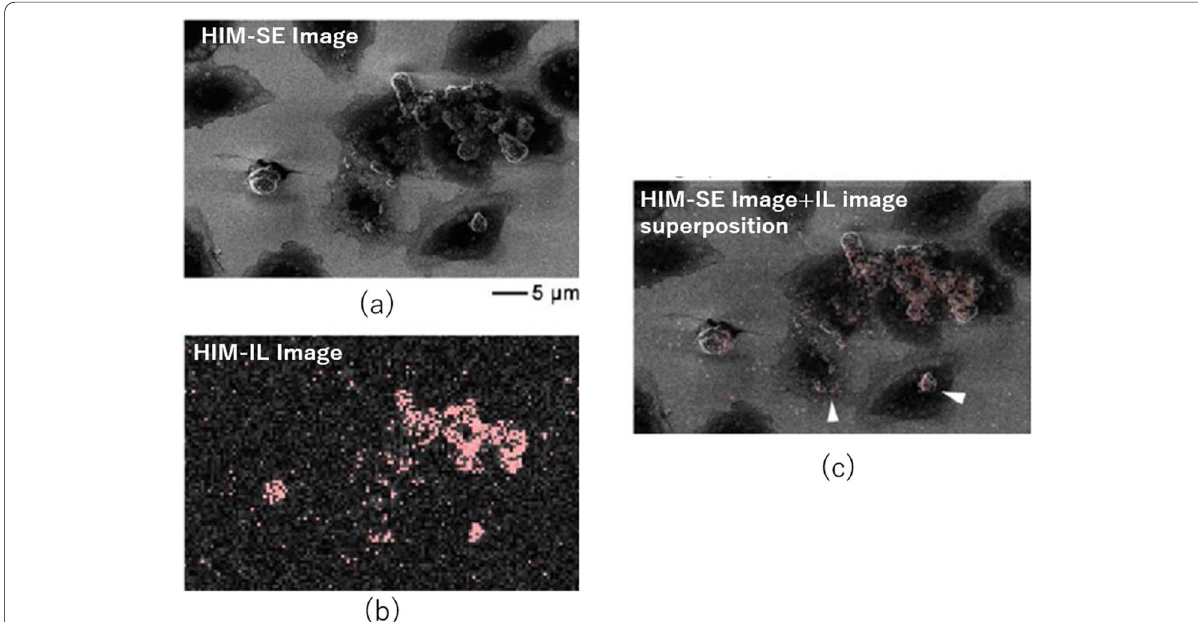
Fig. 11 HIM IL images of the antigenic determinants of renal fibroblasts labeled with ZnO particles. a An SE image acquired using HIM, b an IL image, and c superimposed SE and IL images. Figure modified from